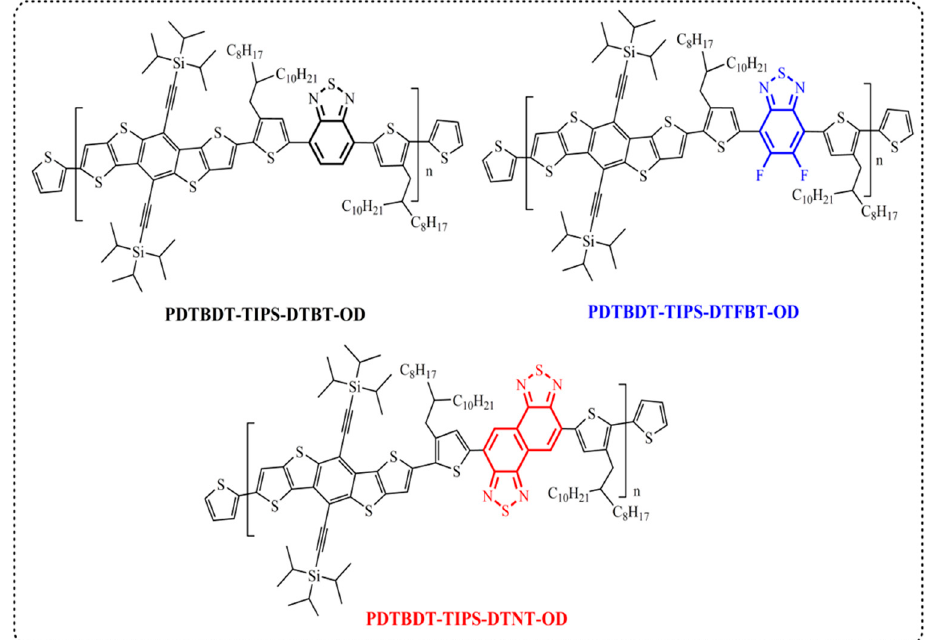
Figure 1 The structures of the studied copolymers. Figure 1. The structures of the studied